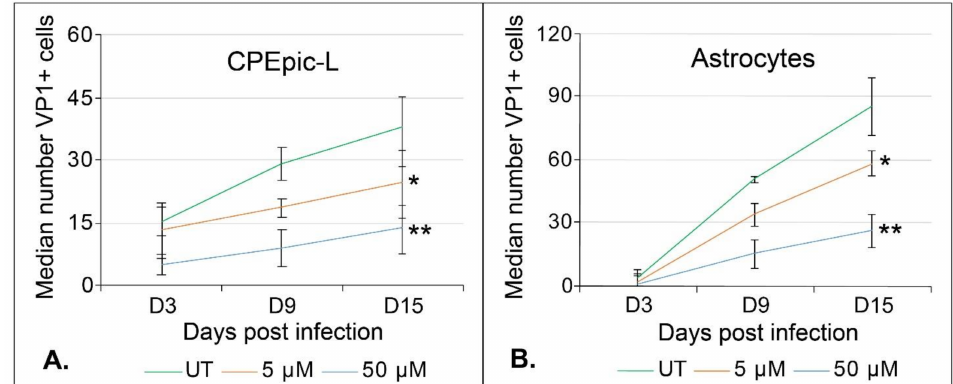
Figure 3. Teriflunomide inhibits the spread of JCPyV in CPEpic-L and primary astrocytes. CPEpic-L ( A ) and primary astrocytes ( B ) were infected with JCPyV and treated with volume-matched vehicle control (DMSO) or with teriflunomide 24 h post infection. The cells were maintained for 15 days with weekly changes of media that contained vehicle or teriflunomide. Infectivity was measured by staining the cells for indirect immunofluorescence analysis of VP1. The median value of VP1+ cells is reported. Teriflunomide significantly reduced JCPyV spread in both CPEpic-L and in primary astrocytes at 9 and 15 days post infection when treated with 50 µ M and at 15 days post infection when treated with 5 µ M teriflunomide. (* p < 0.05, Student’s t -test, ** p < 0.01, Student’s t -test). Error bars indicate the interquartile range (IQR) of each